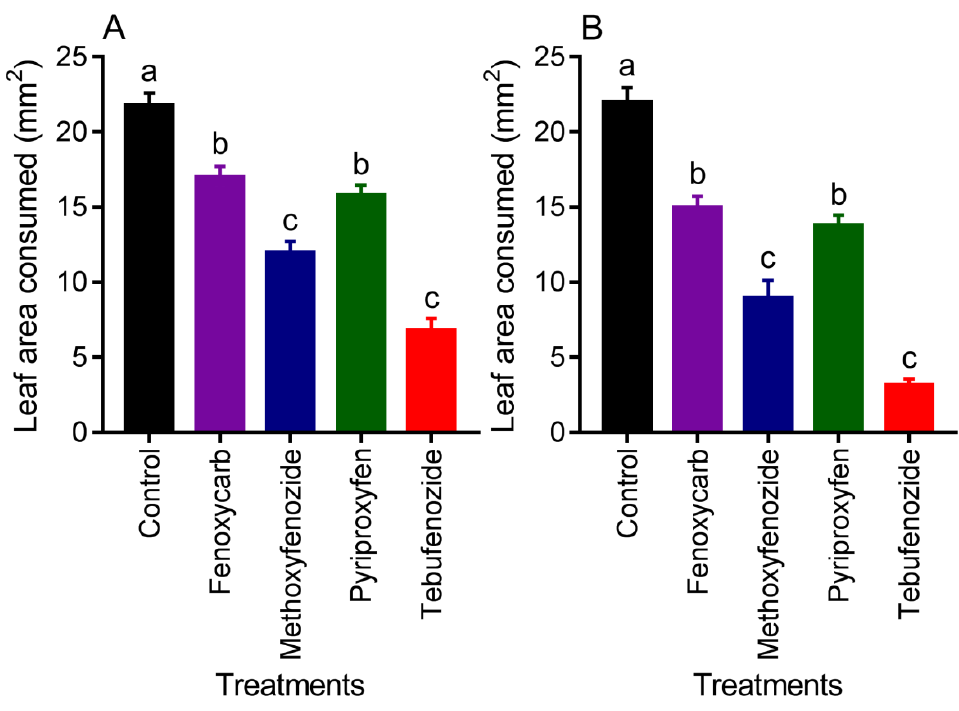
Figure 2. Leaf consumption (mean ± SEM) by Euprosterna elaeasa larvae exposed to insect growth regulators (IGRs): ( A ) LC 50 and ( B ) LC 95 . Treatments means with different letters show significant differences by Tukey’s HSD test at the p < 0 . 05 level.